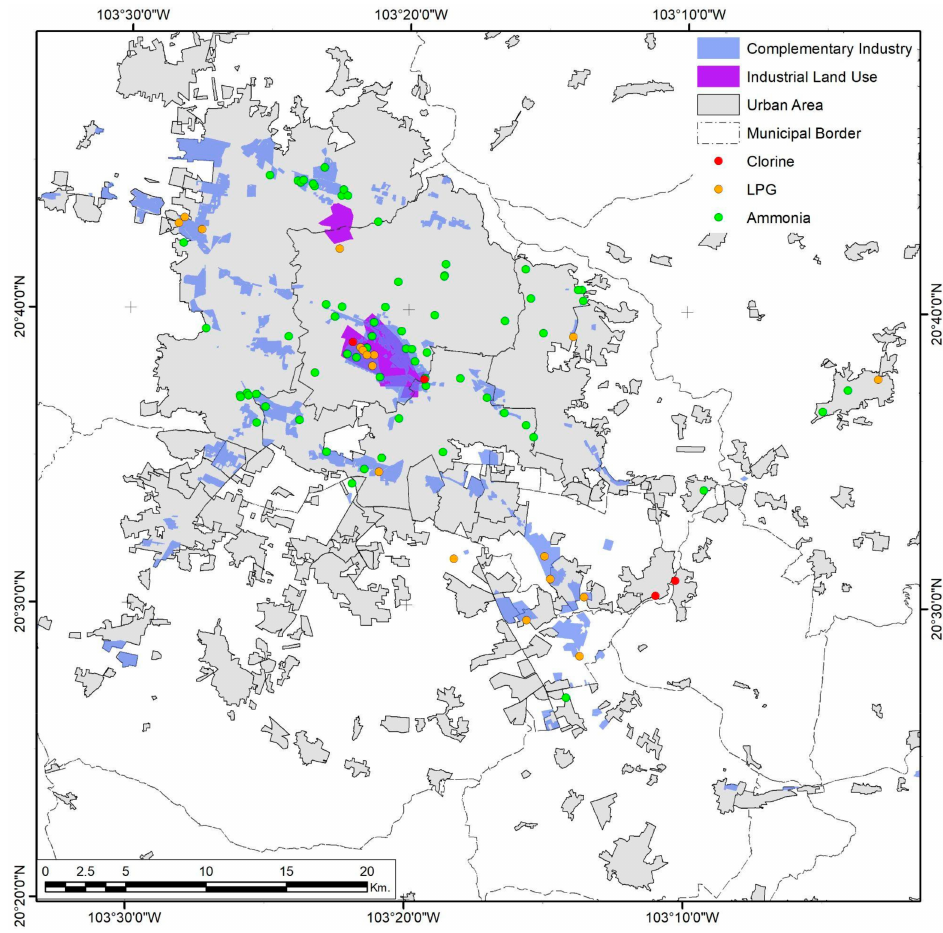
Figure 3. Guadalajara City urban area. The presence of industrial risks and their spatial relationship with industrial coverage. Developed by the authors with data from